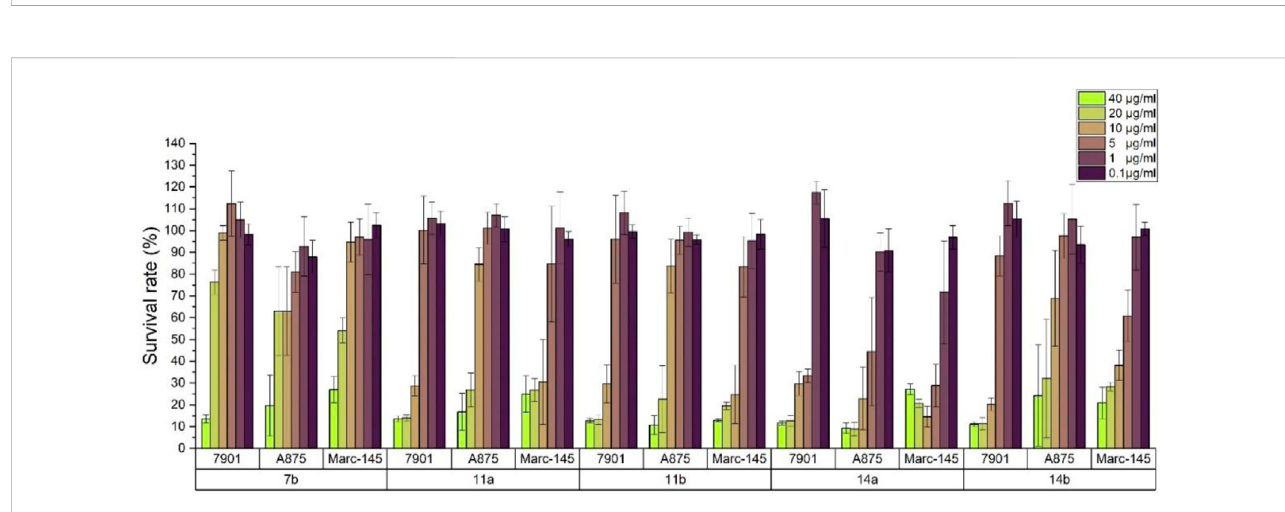
FIGURE 4 Survival rates of 7901, A875 and Marc-145 in different concentration of 7b , 11a , 11b , and 14a , 14b .